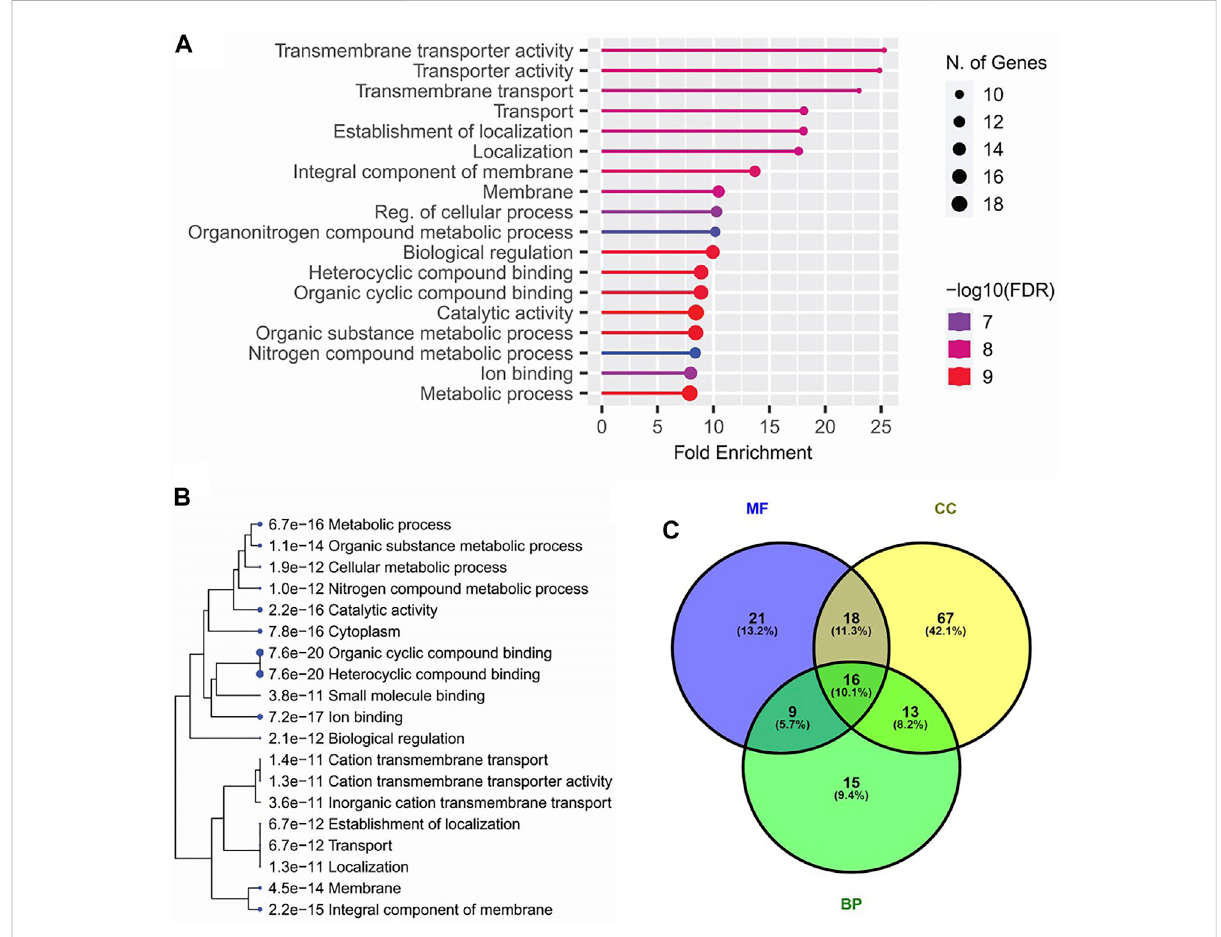
FIGURE 3 Top enriched gene ontological (GO) terms (A) , top enrichedKEGGpathways (B) annotated for the candidate genes within the genomic regions of33pleiotropicQTLs detectedfor four lodging resistance traits,and Venndiagram (C) indicating theoverlapping genesamong GOtermsincluding biological processes (BP), cellular components (CC), and molecular functions